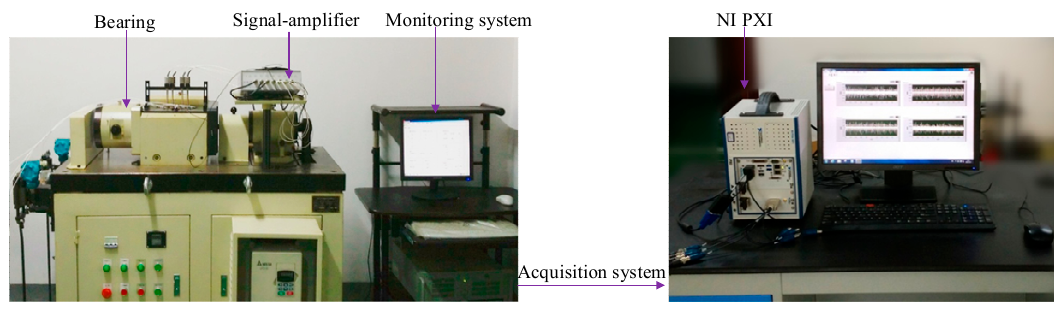
Figure 14. Experimental setup.